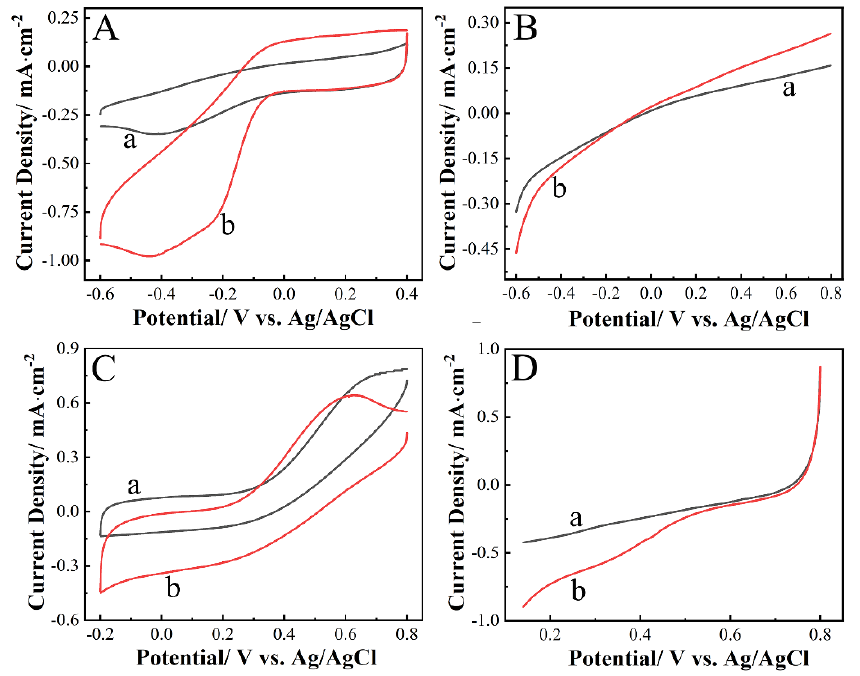
Figure 3. ( A ) CVs and ( B ) polarization curves for the bioanode in 0.10 M PBS (pH 7.4) with (curve a) and without (curve b) 30 mM glucose; ( C ) CVs and ( D ) polarization curves for the biocathode in 0.10 M PBS (pH 7.4) under N 2 − atmosphere (curve a) and O 2 − atmosphere (curve b). The scan rate for polarization curves is 1 mV·s − 1 .